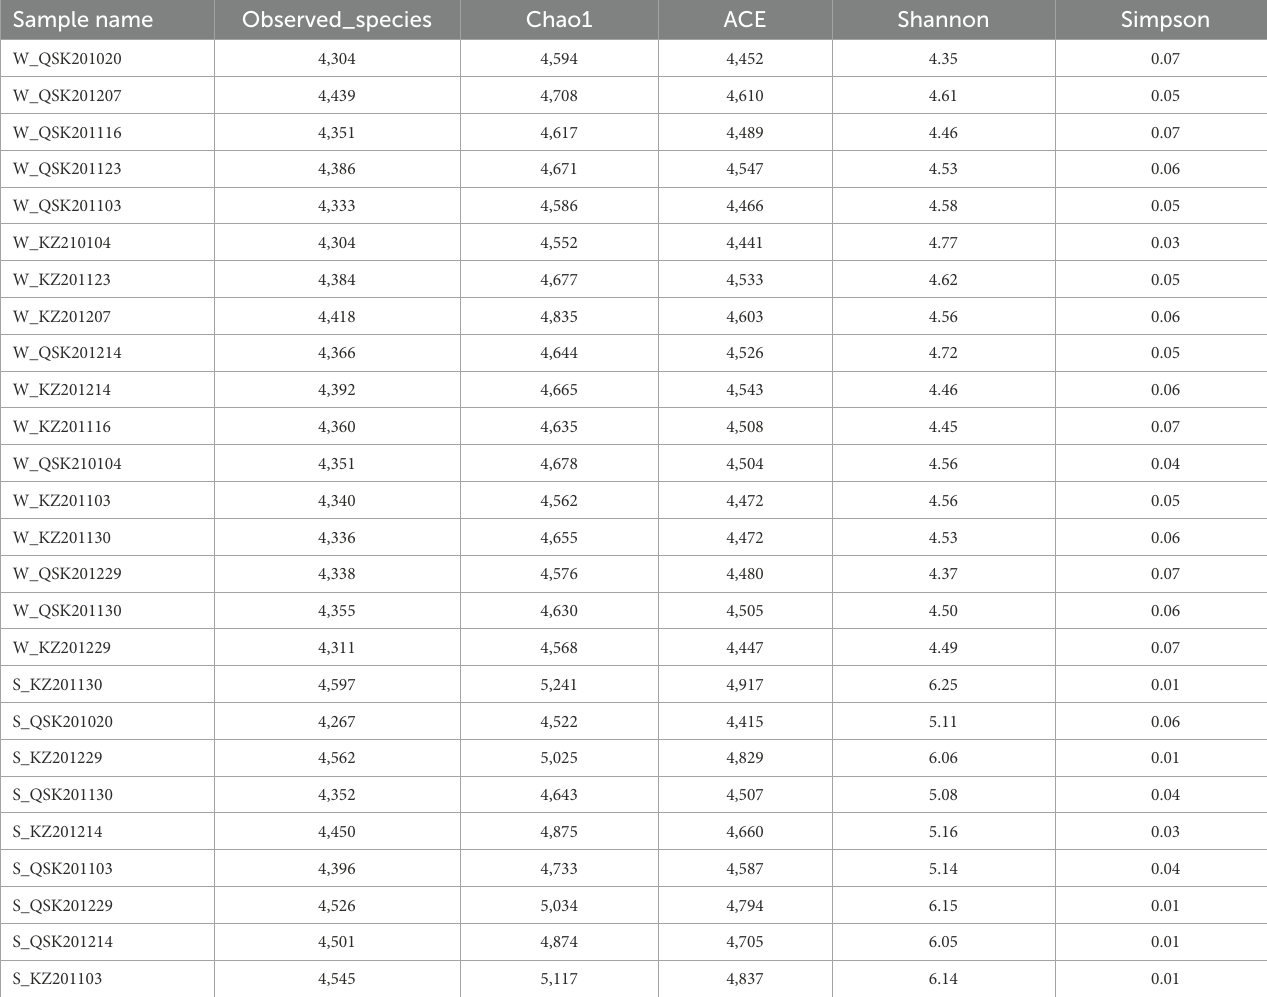
TABLE 2 Relative abundance and diversity of all species community. Sample